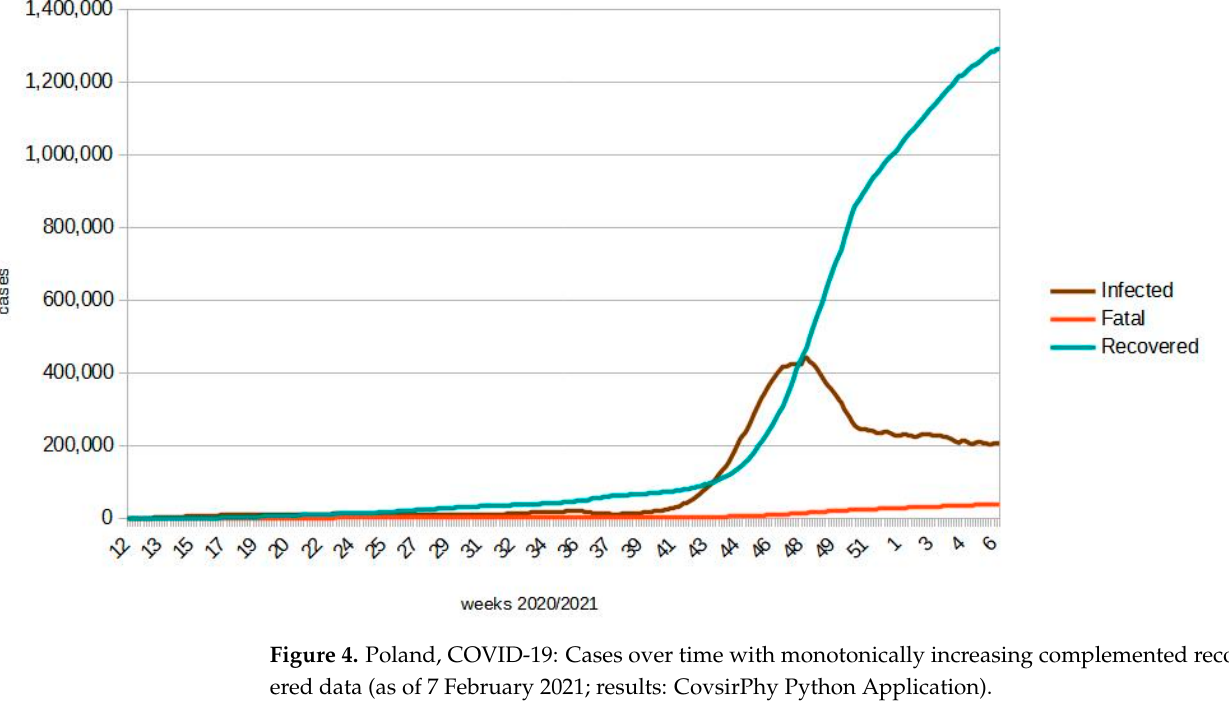
Figure 6. Poland COVID ‐ 19: reproduction number over time (as of 13 February 2021; results: CovsirPhy Python Application). 3.3. Model Calibration–Spatial Interaction The general spatial interaction models used in this article were calibrated by determining parameters based on the analysis of data made available by district (powiat) sanitary and epidemiological stations. The conducted analyses have shown a reliable (in a statistical sense) correlation between the number of inhabitants of individual powiats and the number of cases.